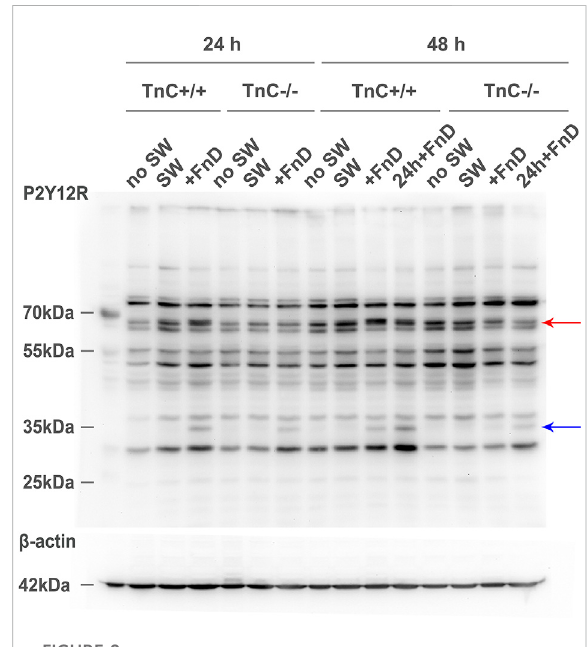
FIGURE 8 Appearance of speci fi c P2Y12R monomeric bands upon FnD treatment.RepresentativeWesternblotimageisshownforP2Y12R and respective β -actin. Blue arrow indicates positions of monomeric bands at ~35 kDa. Additional bands appear only with FnD treatment. Red arrow indicates two bands at the level of dimers ~60 kDa of P2Y12R. In groups treated with FnD, more intense upper band could be seen (more pronounced in TnC +/+ ) ( n = 3 independent